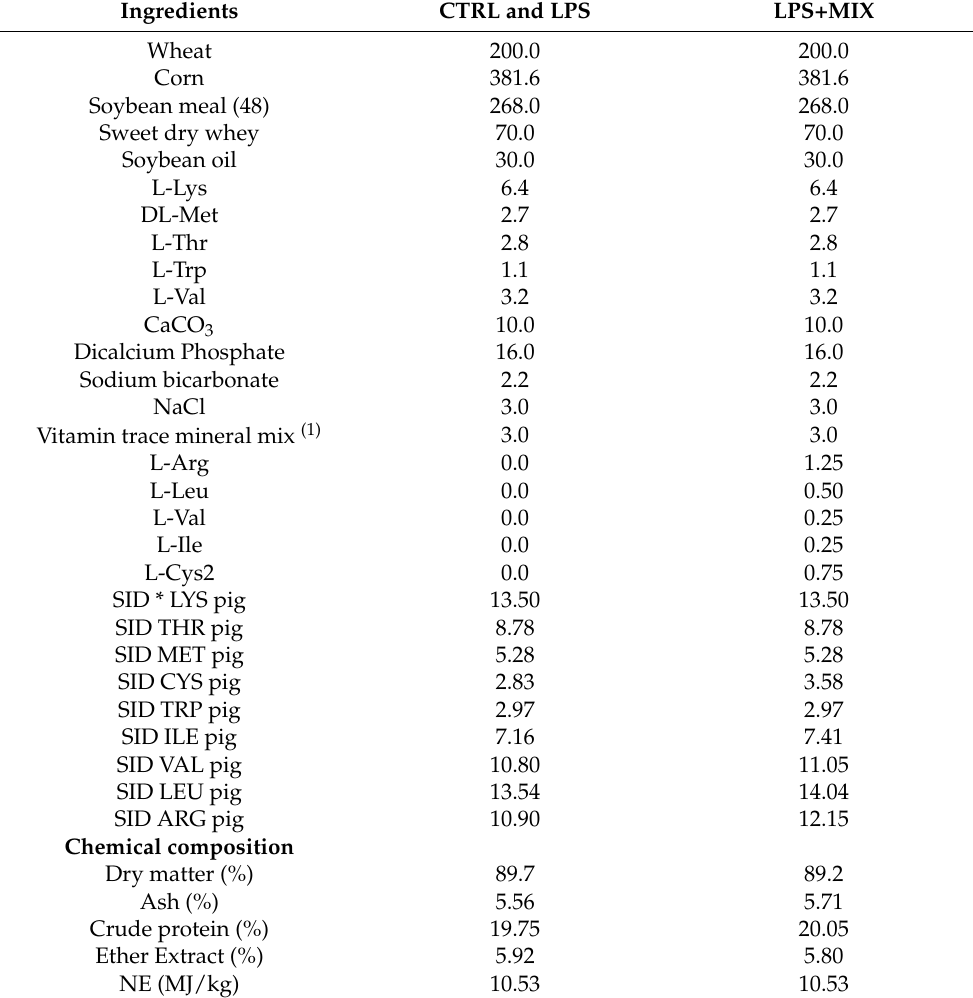
Table 1. Ingredients (g · kg − 1 ) and proximate chemical composition of diets used in the